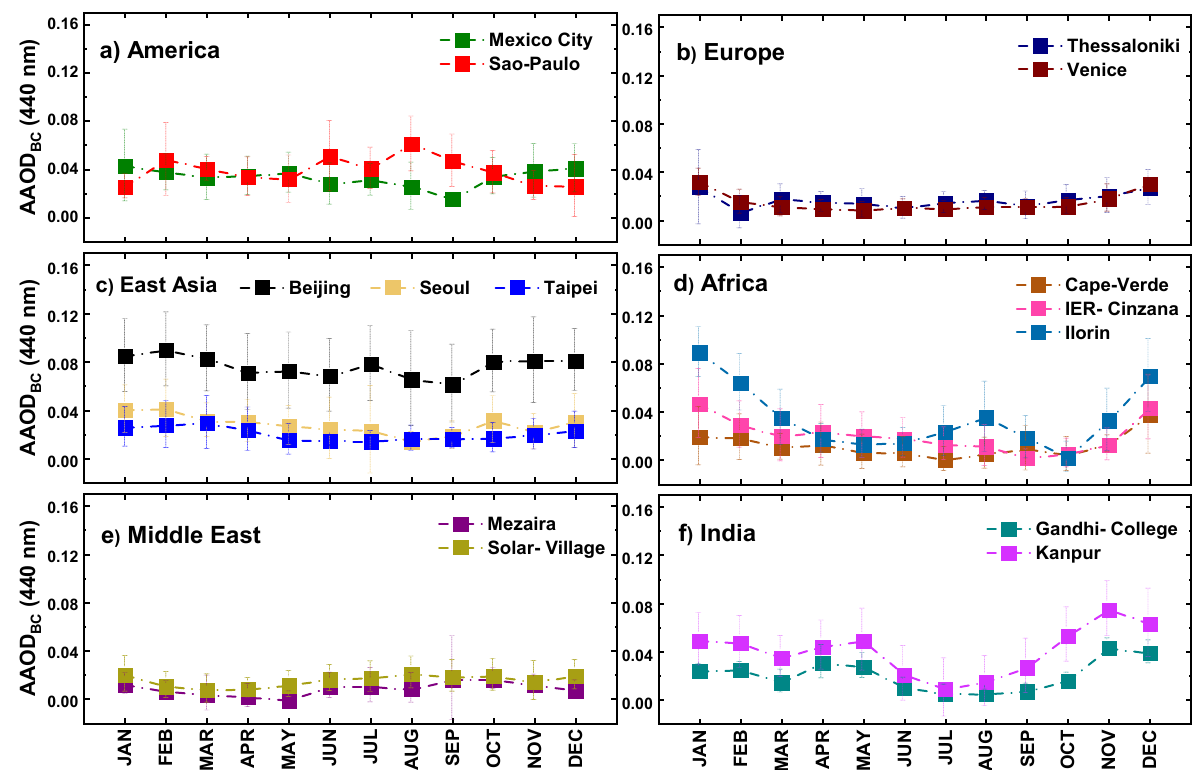
Figure 4. Monthly variations of mean AAOD BC at 440 nm from 2000 to 2018 at fourteen sites. Error bars represent the standard deviation of the monthly averages. (units AAOD BC yr − 1 ).